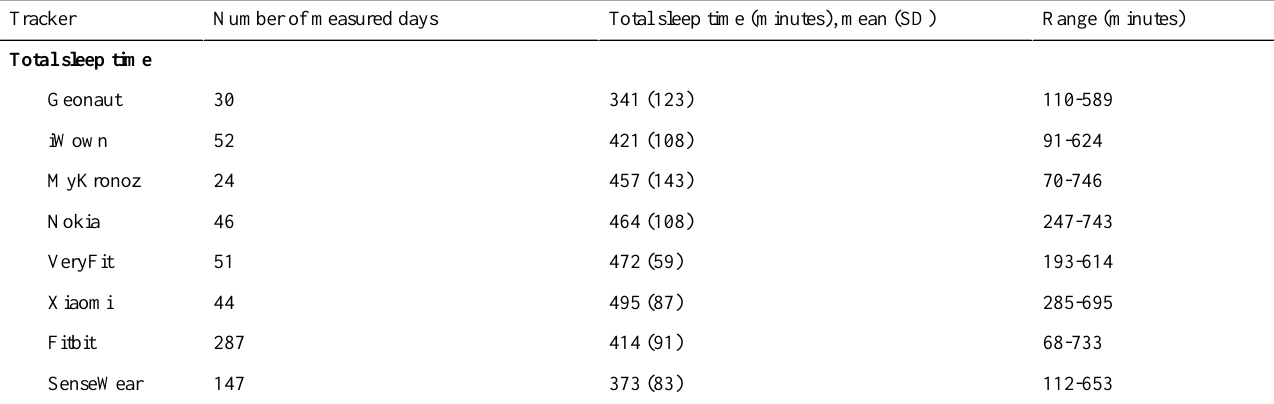
Table 4. Mean total sleep time per day measured by the low-cost trackers, Fitbit and